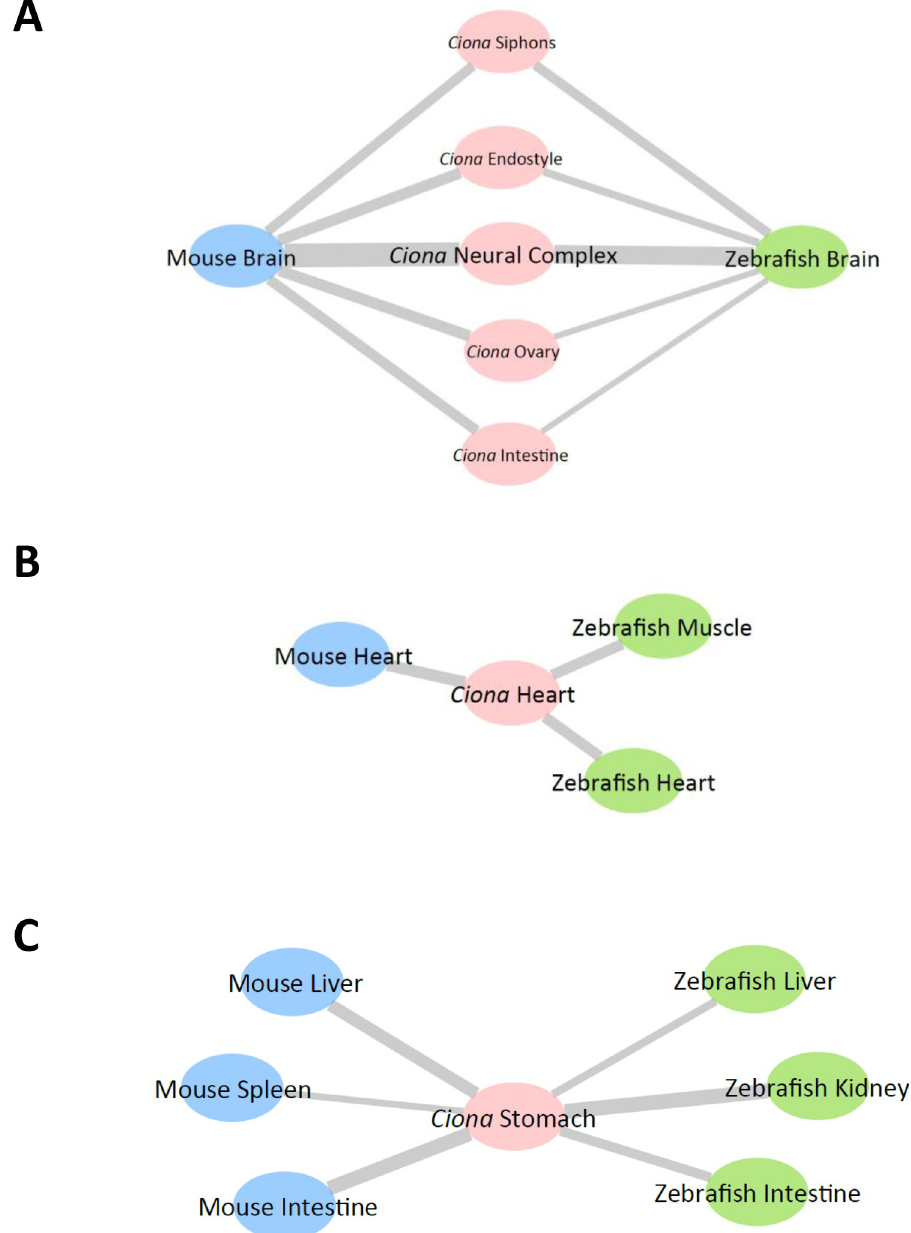
Fig 5. Schematic summary of the comparative analyses of the brain, heart, and stomach. Similarities in gene expression patterns between the Ciona and zebrafish or mouse tissues illustrated using Cytoscape software (ver. 3.8.2.). Ciona , zebrafish, and mouse tissues are shown as pink, green, and blue nodes, respectively. The width of the lines represents the similarity between the tissues. (A) The Ciona neural complex and several other tissues showed high similarities to the zebrafish and mouse brain. (B) The Ciona heart was similar to the corresponding heart and muscle of vertebrates. (C) The Ciona stomach was not similar to the mouse stomach, but rather was similar to several other tissues including the liver, kidney, and